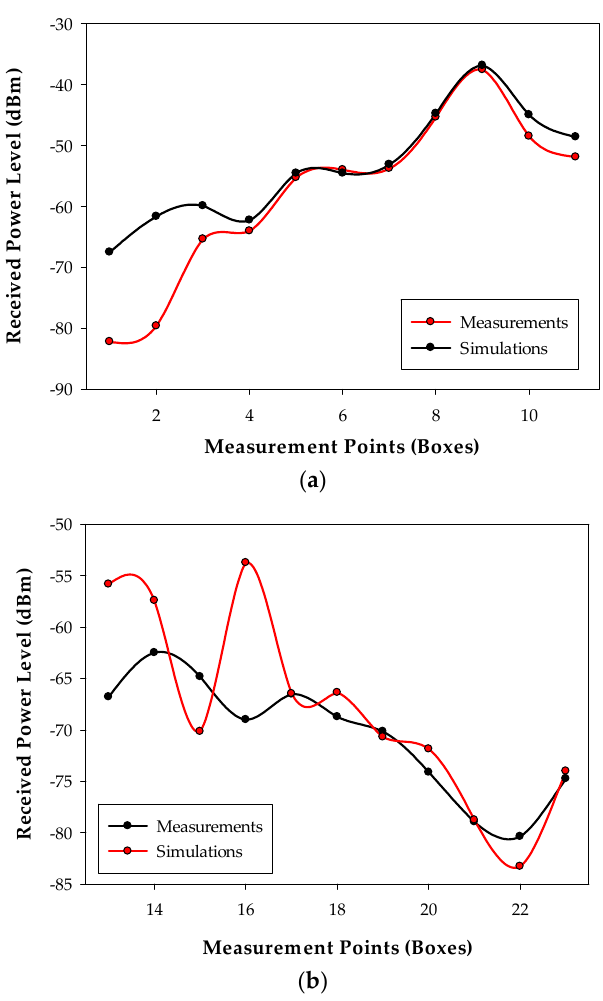
Figure 13. Measurements vs. 3D Ray Launching simulation results: ( a ) for Boxes 1–12; and ( b ) for boxes 13–24.